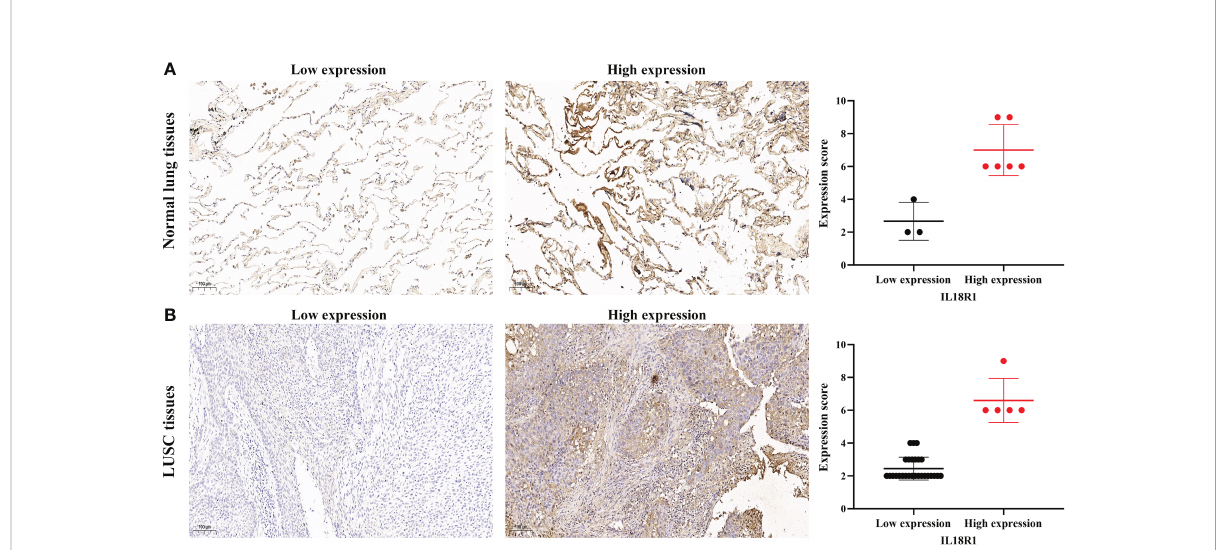
FIGURE 2 IL18R1 was signi fi cantly downregulated in the LUSC tissues of our hospital. (A) Normal lung tissues; (B) LUSC tissues. LUSC, lung squamous cell carcinoma.